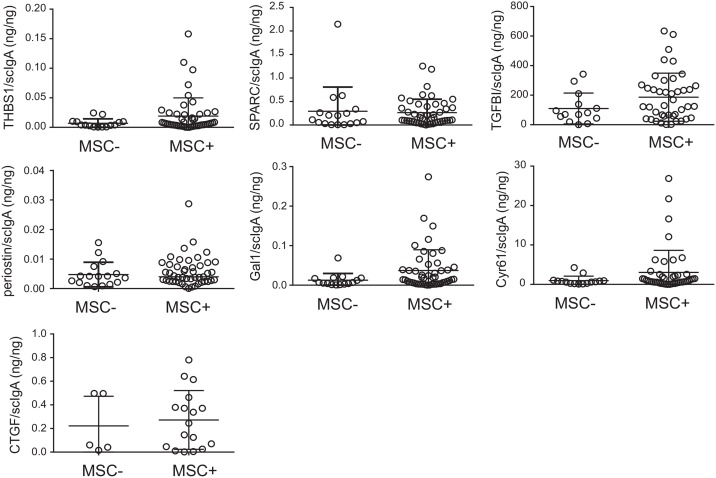
Mesenchymal stromal cell (MSC) isolation does not influence tracheal aspirate matricellular protein concentration.Tracheal aspirate matricellular protein and secretory component of IgA (scIgA) concentrations were measured by ELISA or multiplex immune assay. The isolation of MSCs from tracheal aspirates had no influence on matricellular protein concentration. The data show individual matricellular protein levels normalized to scIgA concentration. Medians and interquartile ranges are shown. Statistical significance was determined by Mann-Whitney U test.